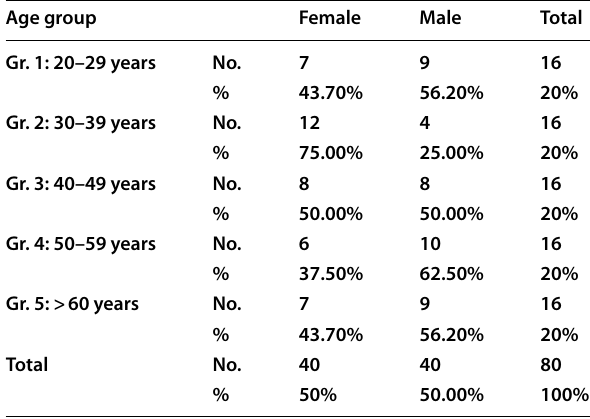
X 2 5.5 = p 0.2397 = There was no statistically significant difference ( p > 0.05) among them regarding gender